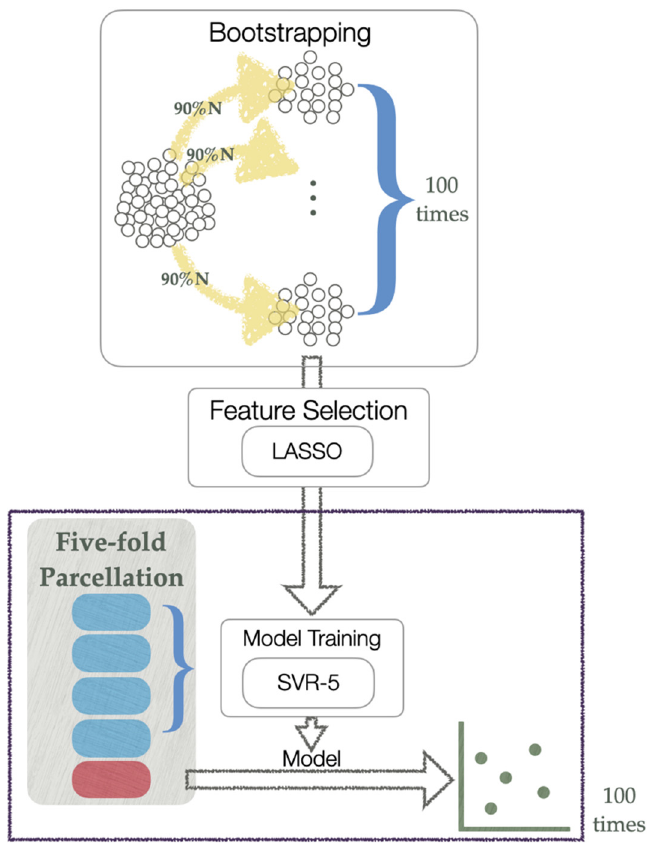
Figure 1. Flowchart of the model prediction procedure. Blue squares are the folds for model training and red square is the fold applied to the trained model. LASSO, least absolute shrinkage and selection operator. SVR-5, support vector machine with five-fold cross-validation.